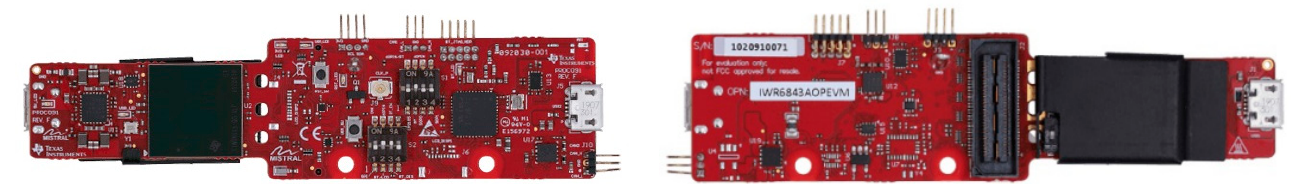
Figure 1. The overview of the proposed gesture recognition system.